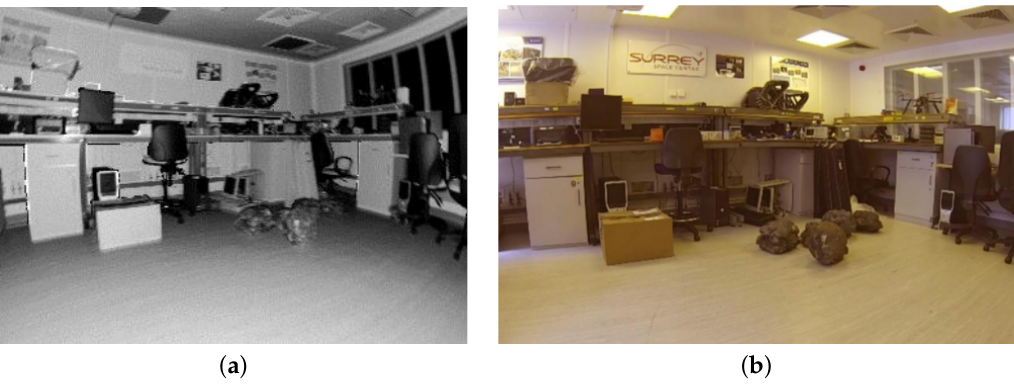
Figure 10. Image produced from LIDAR intensity measurements ( a ) of the laboratory setup ( b